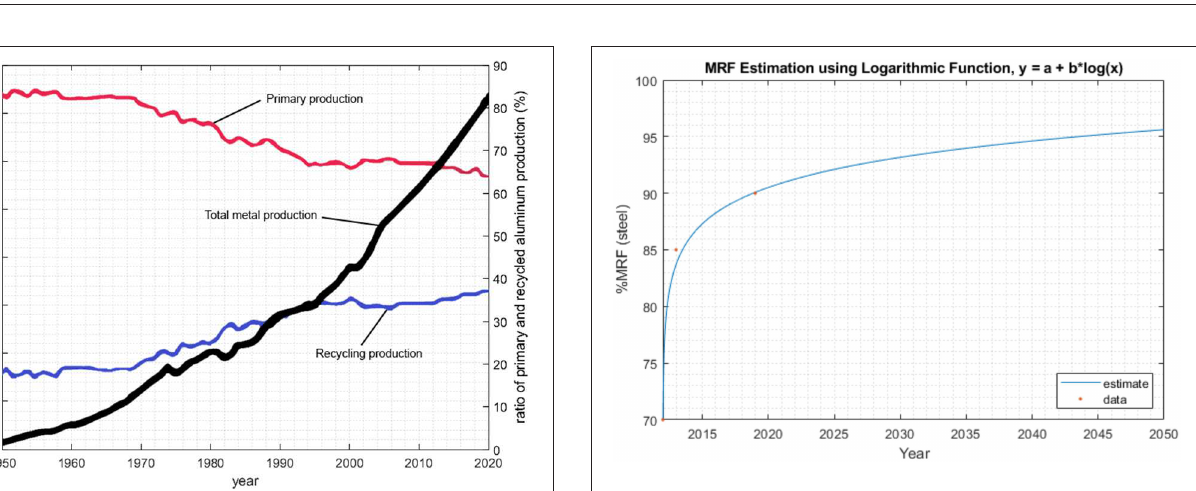
FIGURE 3 | The estimation of MRF values of mixed aluminium and